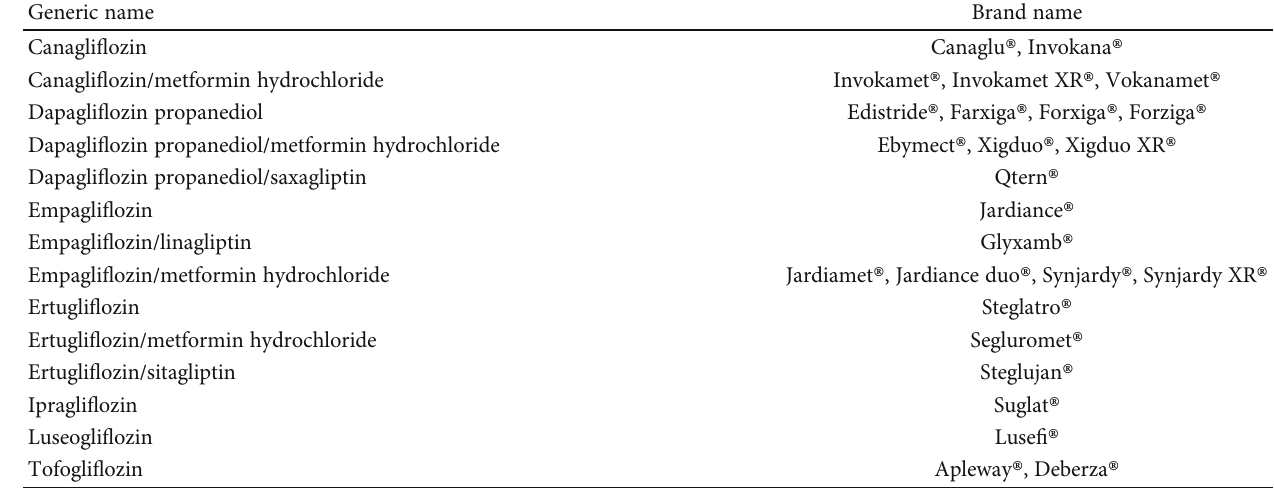
Table 1: Summary of the generic name and brand name of SGLT2 inhibitors based on MICROMEDEX®.